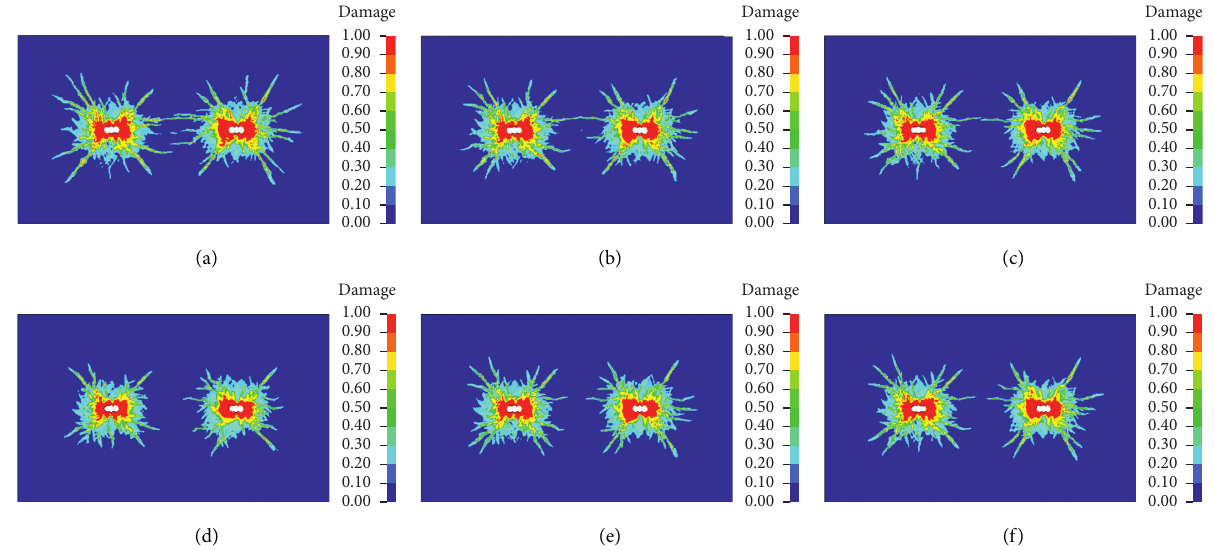
Figure 4: Effect of double-hole blasting of cutting seam charge under different ground stress. (a) σ